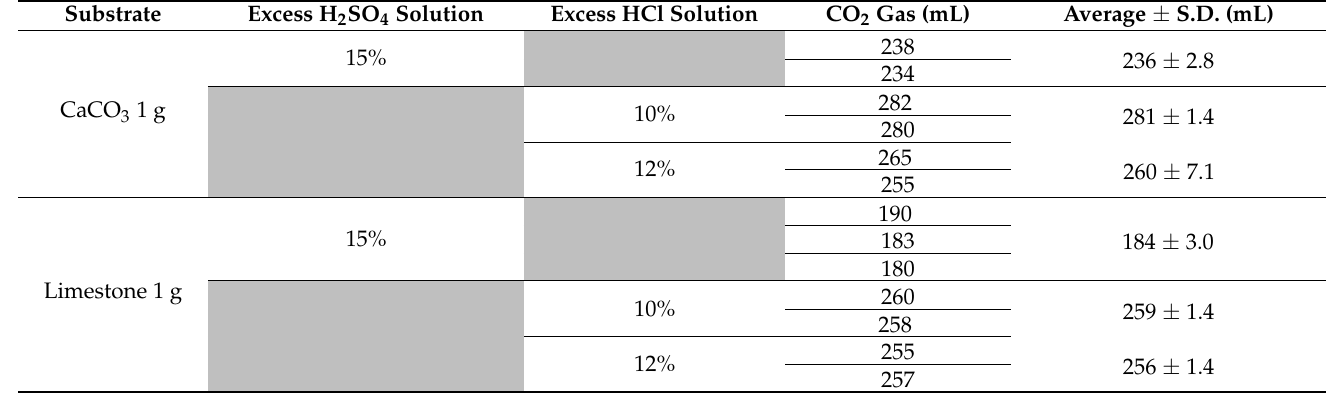
Table 1. Amount of CO 2 gas produced by the reaction between 1 g of limestone and excess acid solution, compared with 1 g of calcium